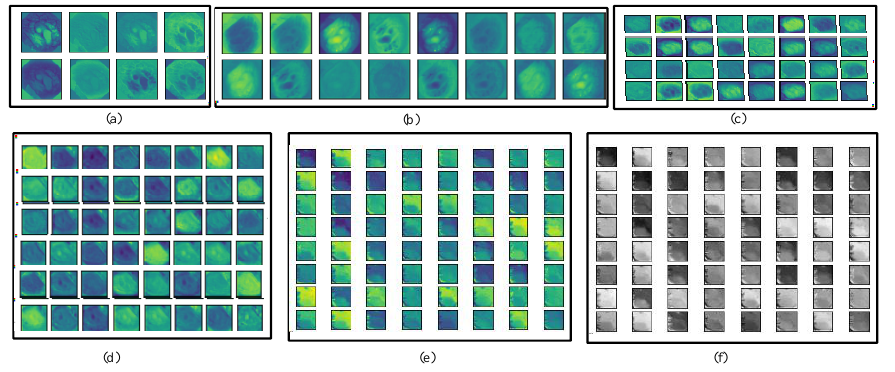
Figure 4. Visualization of various layers of Graft-U-Net. ( a ) C1, ( b ) C4, (c) C7, ( d ) C10, ( e ) C13, and ( f ) C13 (gray level).